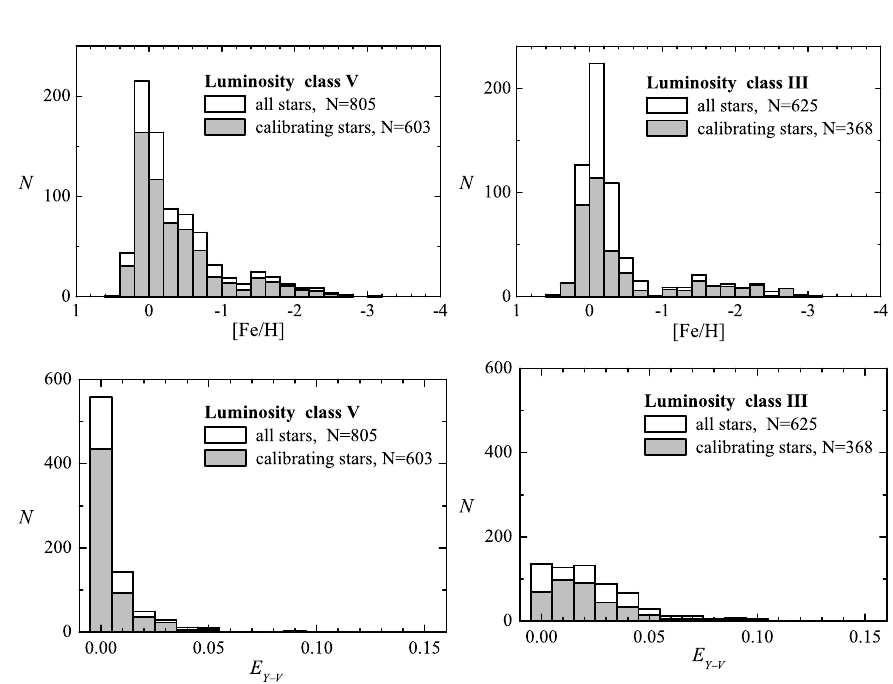
Fig. 2. Distributions of dwarf and giant stars by metallicity (top panels) and by values of interstellar reddening, E Y − V (bottom panels). Unshaded histograms represent all stars in the sample, whereas shaded histograms indicate calibrating stars left after removal of binaries, variables and stars with inaccurate photometry or with discrepant values of spectroscopic